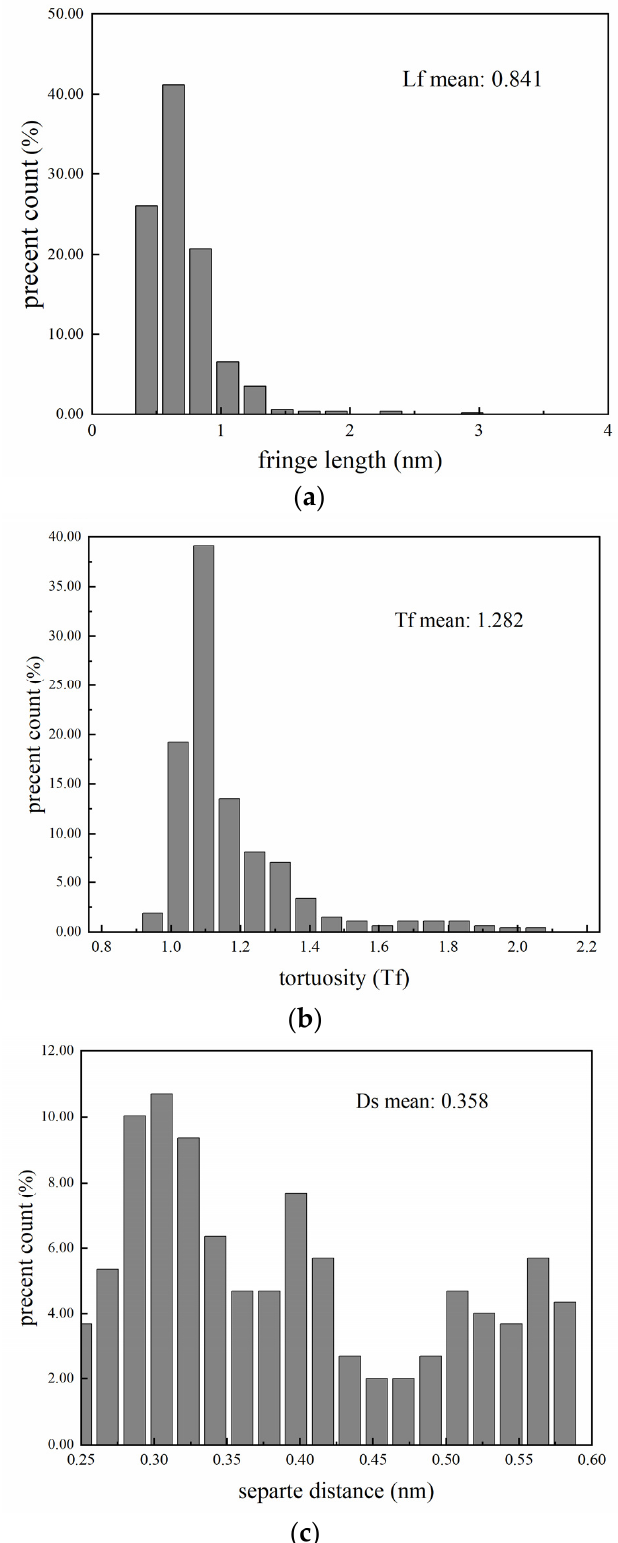
Figure 5. Histograms of the fringe length (Lf), tortuosity (Tf), and separation distance (Ds) for the GDI PM. ( a ) fringe length; ( b ) tortuosity; ( c ) separation